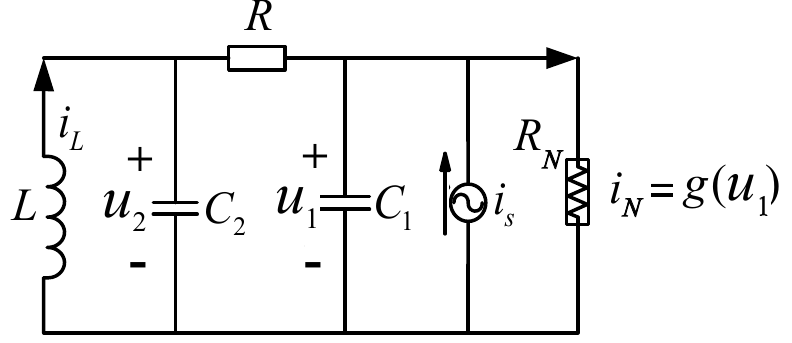
Figure 1. 3D Filippov-type slow–fast Chua’s circuit